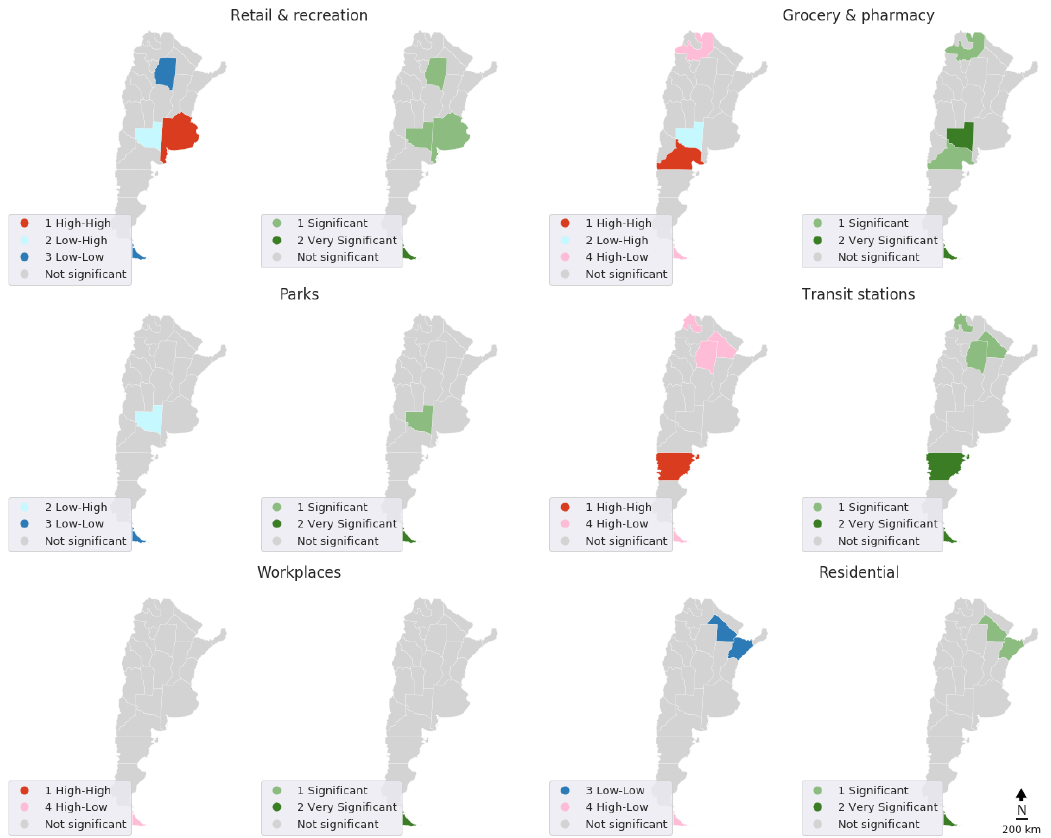
Figure 20. Cluster maps and LISA significance maps for Google categories from 1 June to 27 October 2020: Argentina. Source of basic data: Covid-19 Community Mobility Reports, Google.